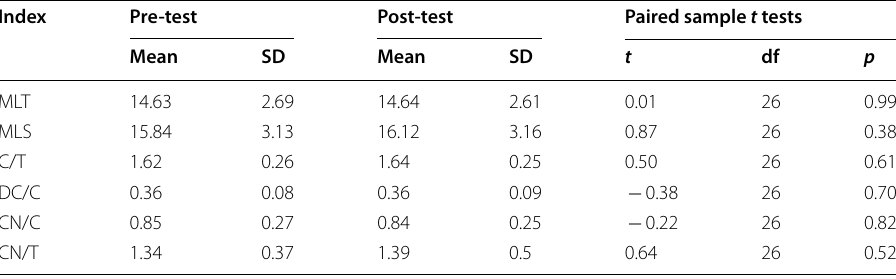
Table 3 Comparisons of syntactic complexity measures in the pre-and post-tests